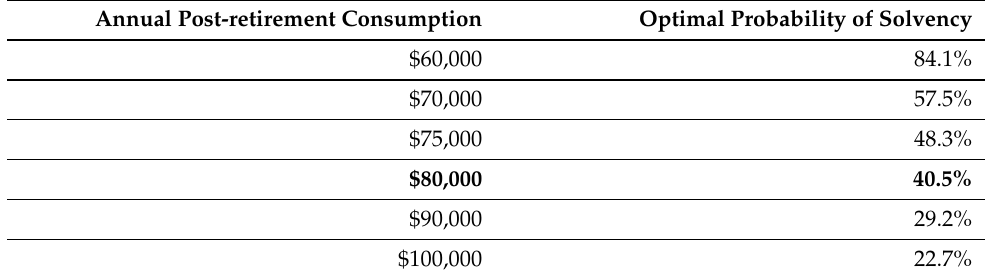
Table 15. The effect on Investor #2 of varying the post-retirement consumption, in t = 0 post-tax dollars, from its normal value (in bold).